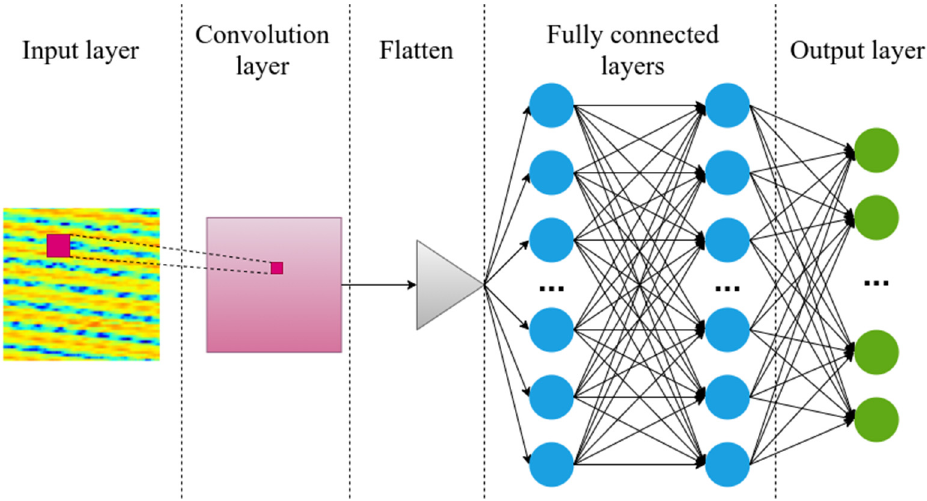
Figure 6. Convolutional neural network consisted of six layers.